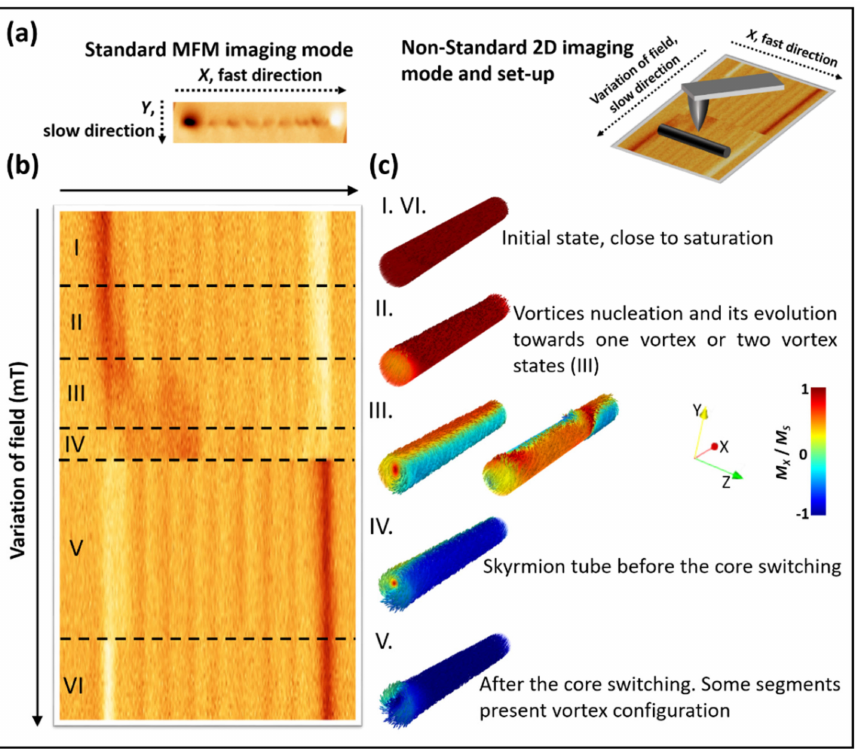
Figure 2. ( a ) Sketch of 2D mode acquisition process; ( b ) 2D MFM map corresponding to a variation of the field between − 9 and +37 mT. ( c ) Sketch of the magnetic configuration expected for segments in the regions named as I to VI in ( b ) illustrated using mumax3